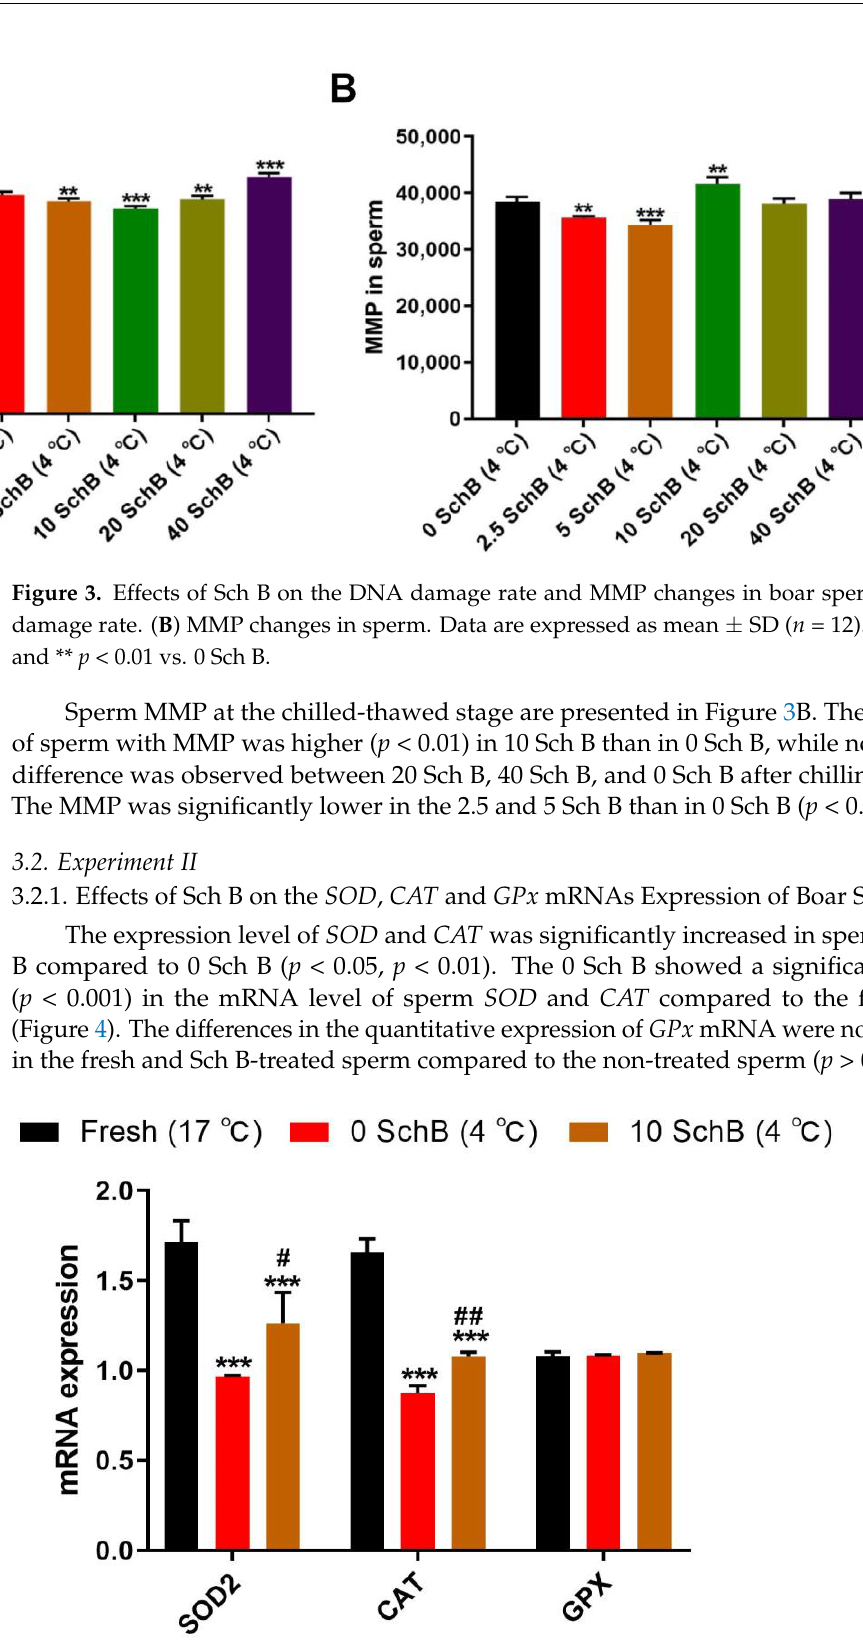
Figure 4. Effect of Sch B on mRNA and of SOD, CAT, and GPx in boar sperm: Data are expressed as mean ± SD ( n = 12). ## p < 0.01 and # p < 0.05 vs. 0 Sch B, *** p < 0.001 vs. fresh.